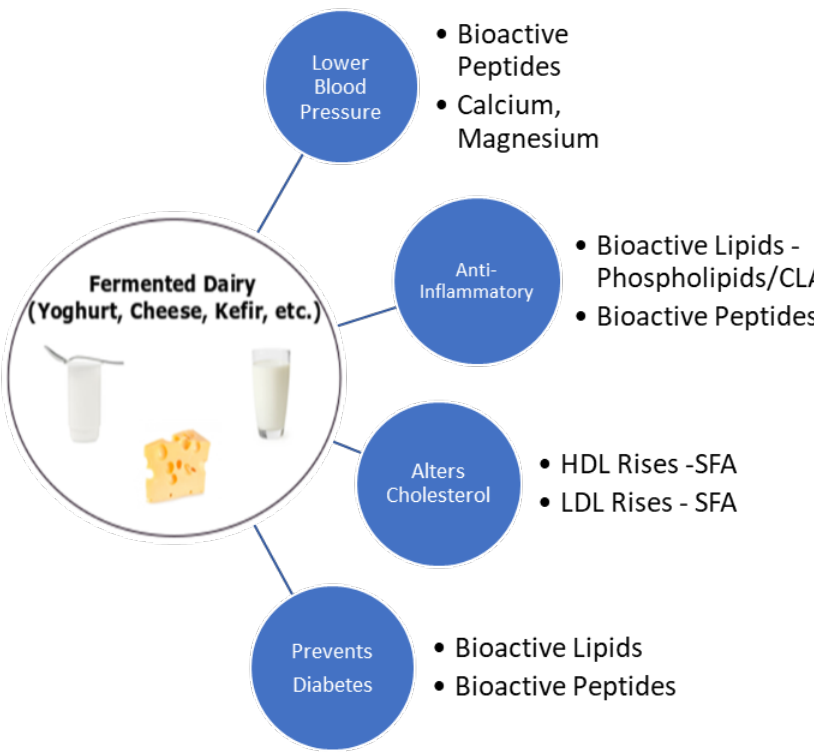
Figure 1. Effects of dairy product consumption on cardiometabolic risk factors and cardiovascular health. CLA: conjugated linoleic acid; HDL: high-density lipoprotein cholesterol; LDL: low-density lipoprotein cholesterol; SFA: saturated fatty acid.